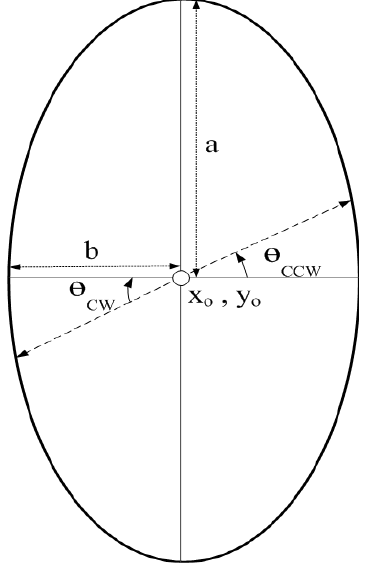
Figure 8. Specifications of elliptical mobility path followed by